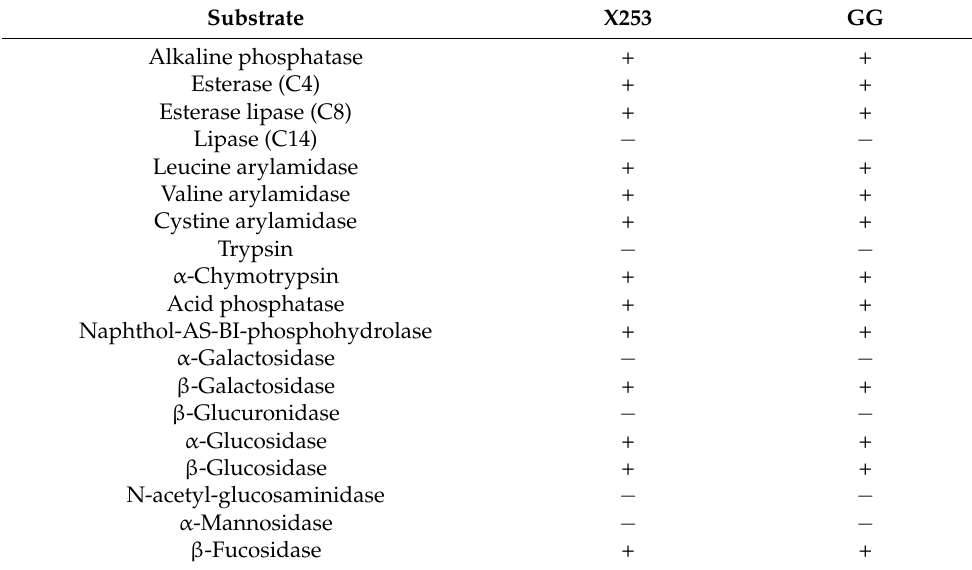
Table 4. Enzymatic profiles and assay of toxic metabolic